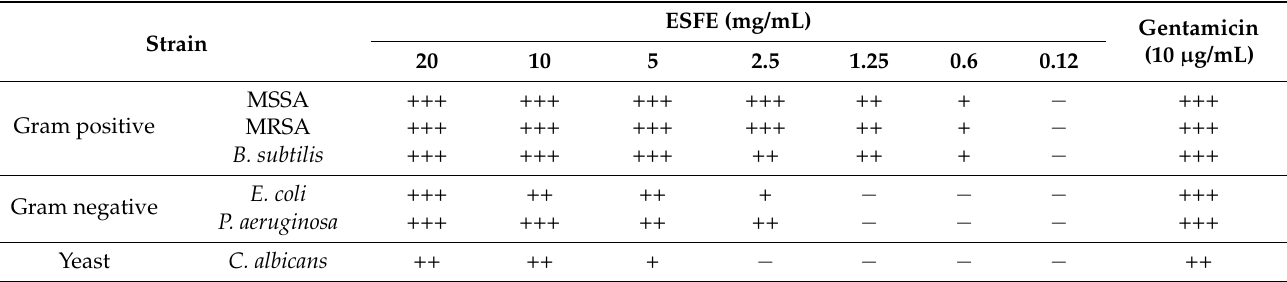
Table 1. Antimicrobial potential of